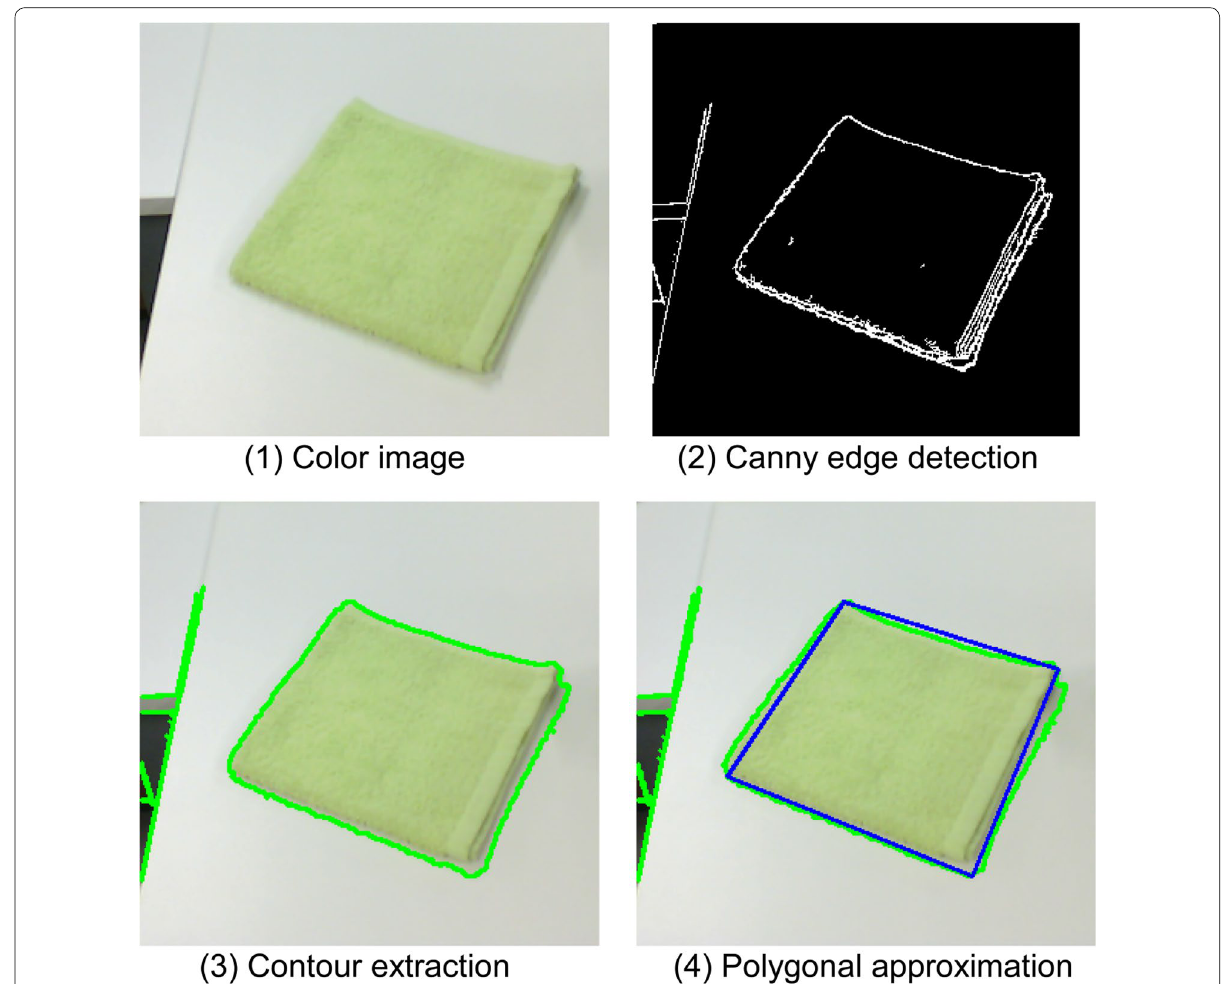
Fig. 3 The procedure of contour